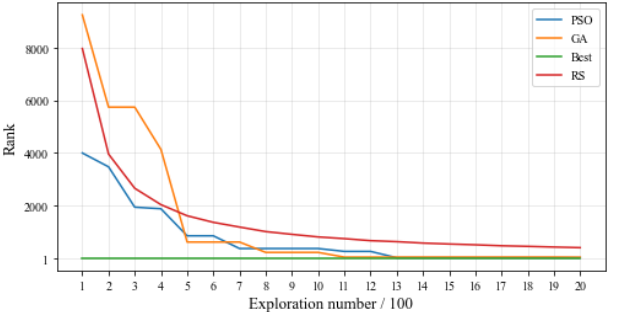
Figure 10. PMU placement ranking based on number of exploration—69-bus system, N m = 4.